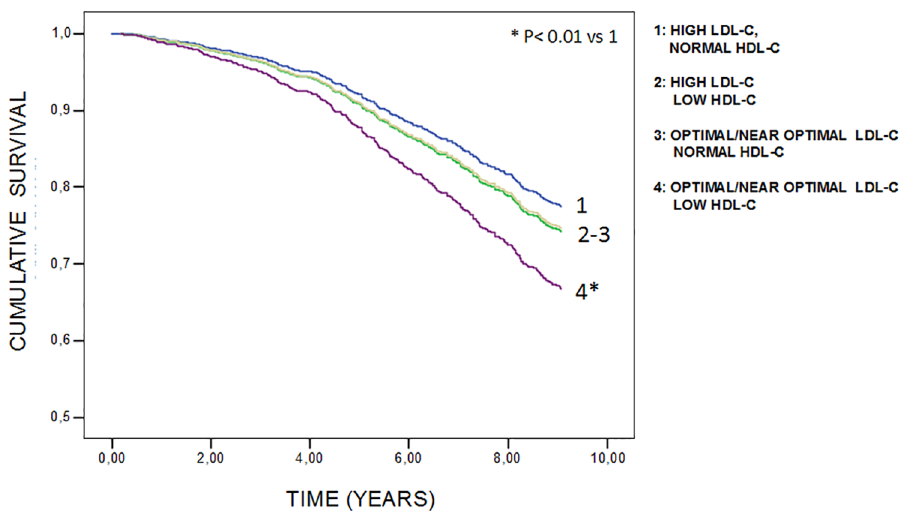
Fig 1. 9 yearscumulative survival curves by multivariate Cox proportional hazards model, in 1044 community dwelling older subjects, according to combined levels of plasma LDL-C and HDL-C (adjusted for age, gender, statin therapy, yearsof school, smoking, alcohol consumption, BMI, creatinine, uric acid, IL-6 plasma levels, serum albumin, hypertension, diabetes,CHD, stroke, CHF, weight loss > 4.5 kg in the last year, and diagnosis of cancer).